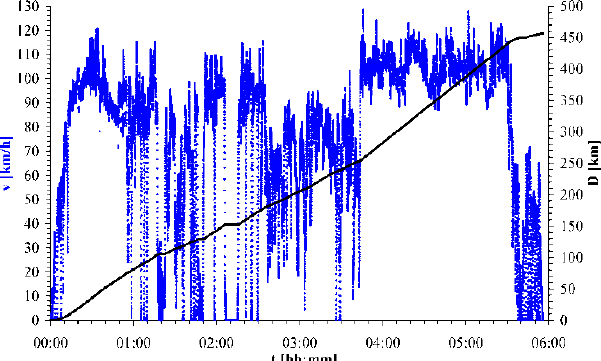
Fig. 11. The waveform of the route and vehicle speed while driving